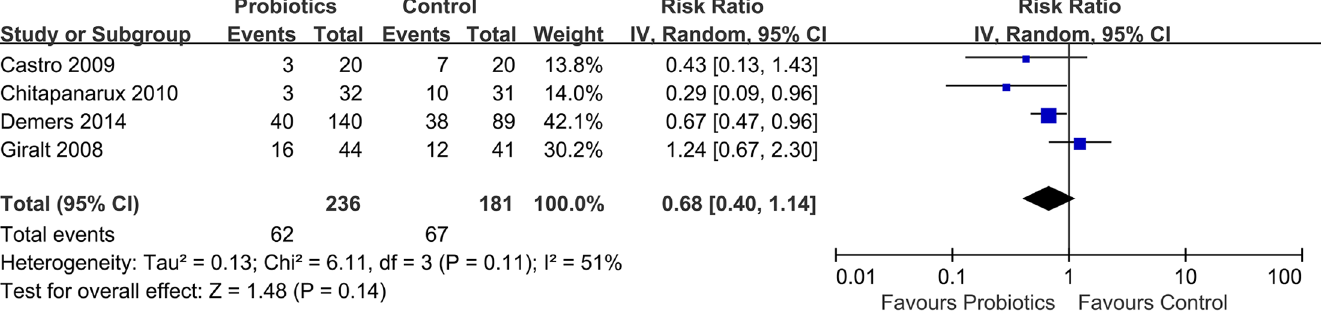
Fig 5. Effect of preventive probiotics on incidence of anti-diarrheal medication use compared with placebo treatment.